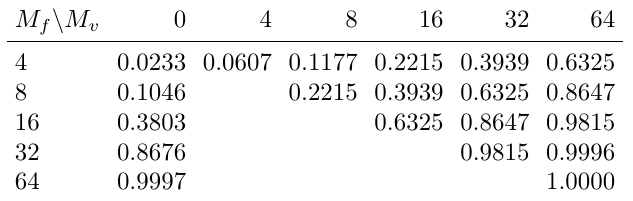
Table 6: Probability of collision with either only faulty queries (under M v = 0) or with M f faulty and M v valid queries ( N = 256). Symmetrical values were